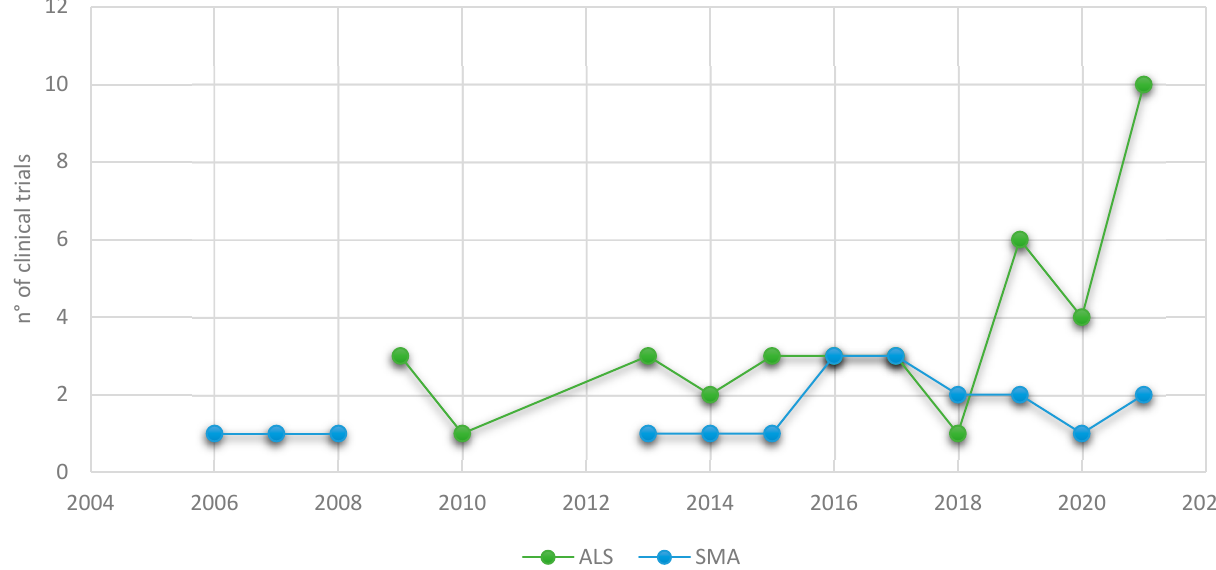
Figure 1. The evolution of interventional clinical trials in ALS and SMA using omics approaches.